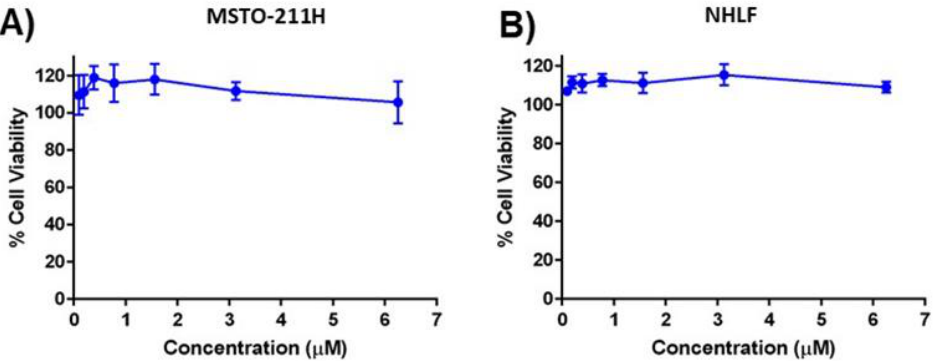
Figure 5. Toxicity study for ( A ). MSTO-211H and ( B ). Normal human lung fibroblast (NHLF) cells. Cells were treated with different concentrations of each treatment for 48 h and the cell viability was measured using an MTT assay. Cells grown in media were considered as the control (100%). Data represent mean ± SD (n = 6).